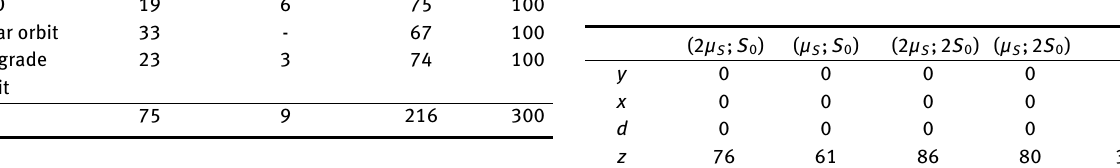
Table 4. SSO simulations: eddy-current rotation for different sets of simulation parameters.